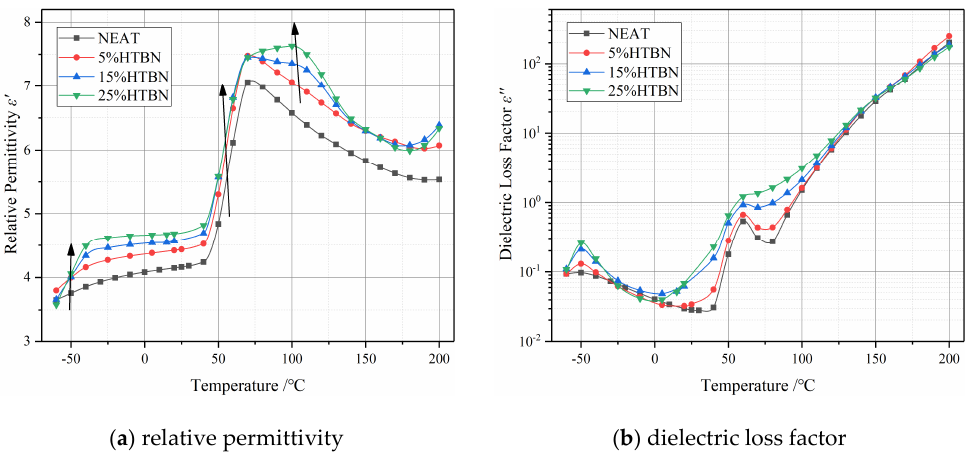
Figure 1. Temperature spectrum characteristics of epoxy resin with different hydroxyl-terminated liquid nitrile rubber (HTBN) contents at 50 Hz: ( a ) relative permittivity; ( b ) dielectric loss factor.